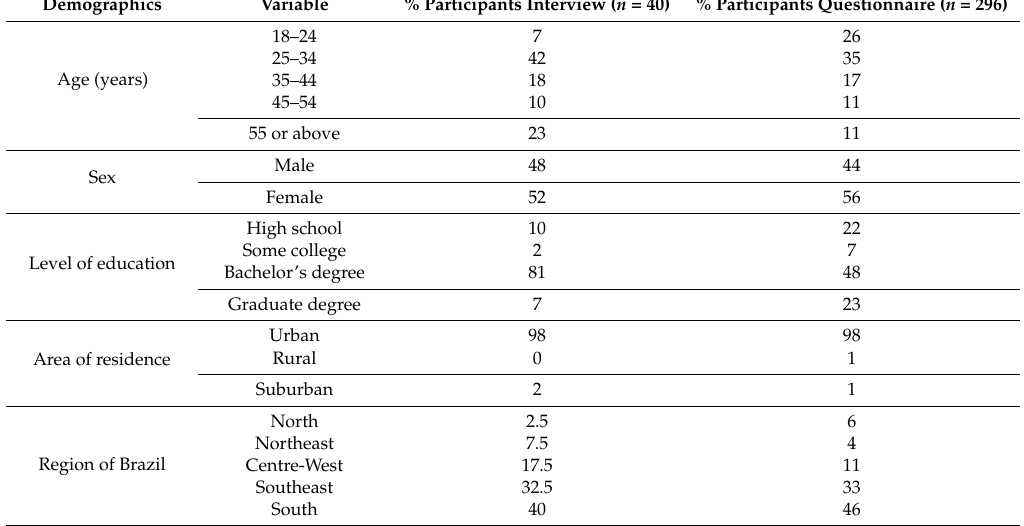
Table 1. Demographics of participants separated by interviews and